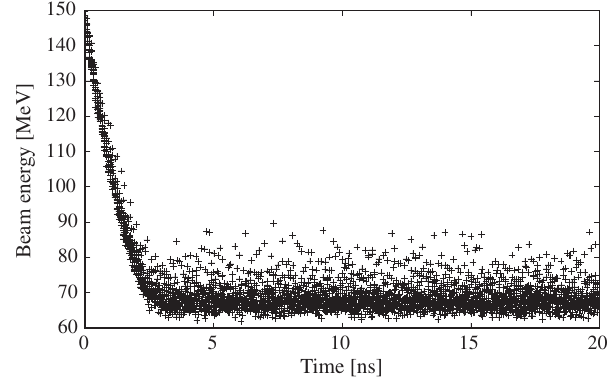
FIG. 1. Energies of simulated particles in the TBL from the PLACET tracking code. Nominal beam parameters were used in the simulation, and the plot shows the first 20 ns out of the 140 ns bunch train. At the start one can easily see the high-energy transient time that occurs due to the field buildup in the